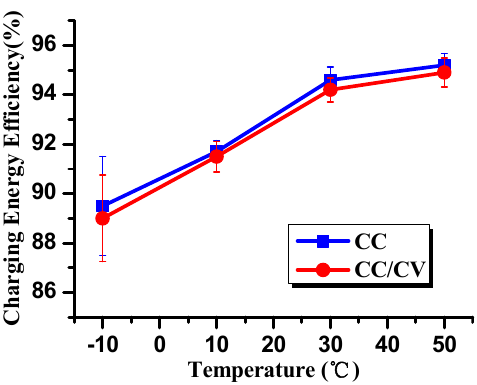
Figure 6. Charging energy efficiencies of CC strategy and CC/CV strategy at different temperatures.